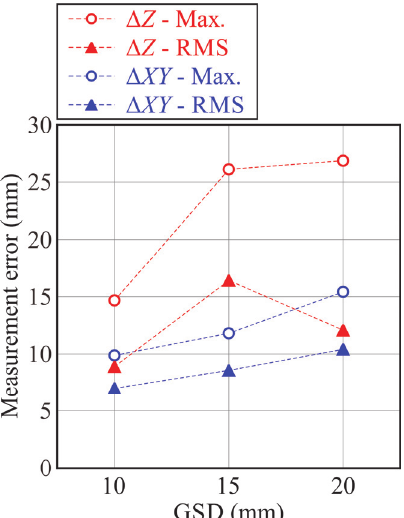
Figure 12. Measurement errors of 9 check points by QC730